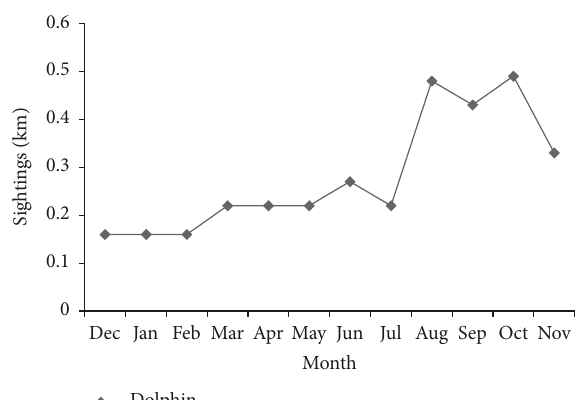
Figure 6: Monthly encounter rates of Ganges river dolphins in the Turag